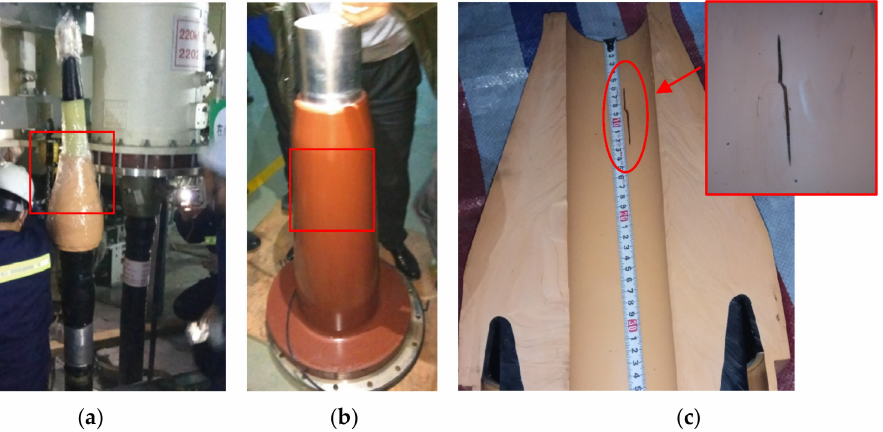
Figure 7. Morphology of the disassembled cable terminal. ( a ) Stress cone and XLPE insulation, ( b ) epoxy sleeve, ( c ) crack inside the stress